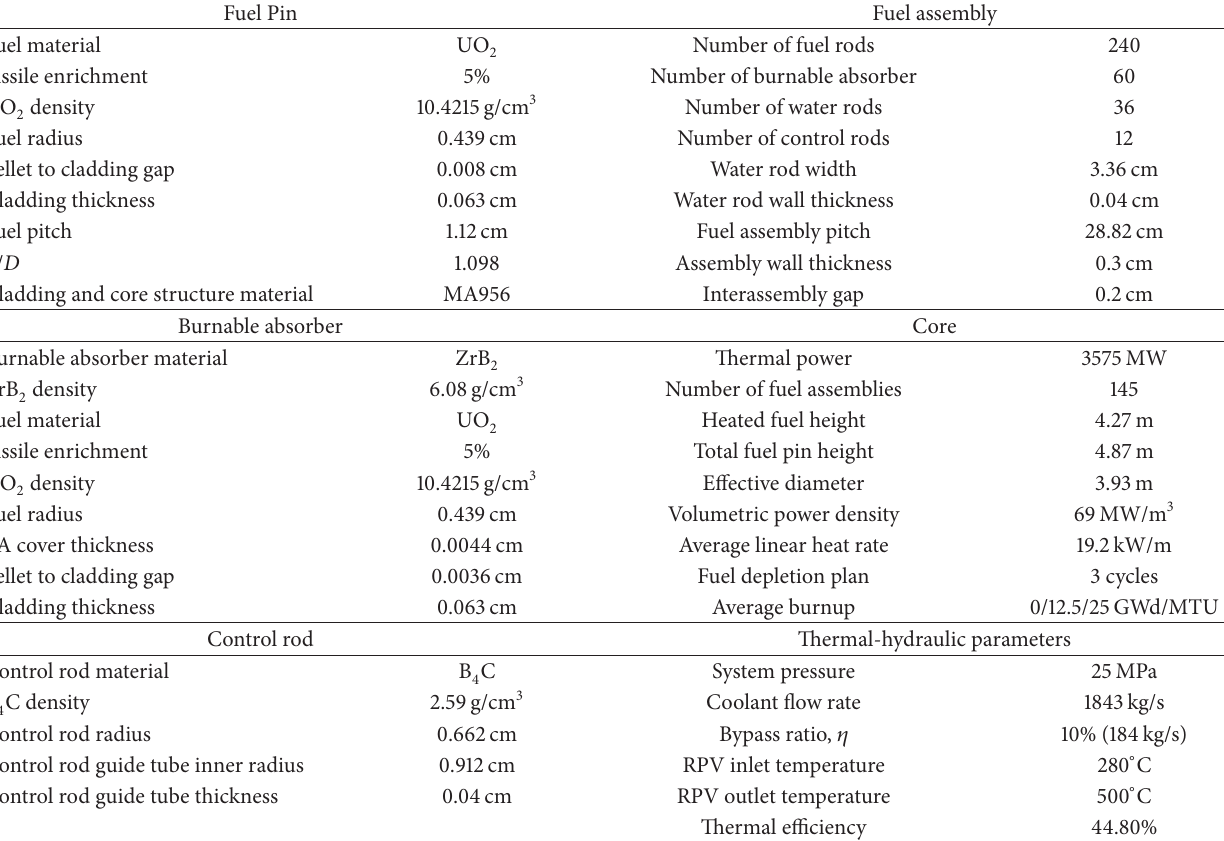
Table 2: SCWR parameters.